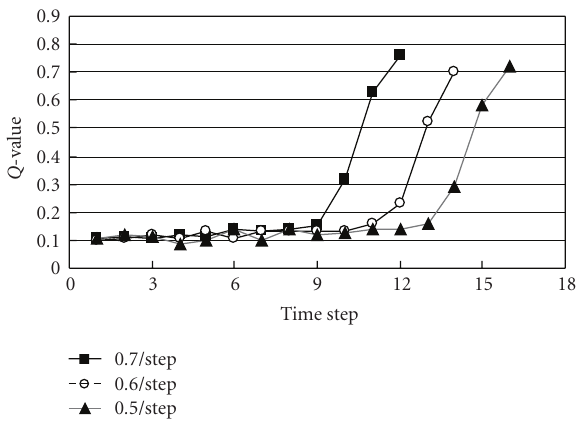
Figure 6: Change in the Q -value for “catch” action for three velocities. The timing for the increase in value di ff ers, but the position of the object at that timing is almost the same in all cases.